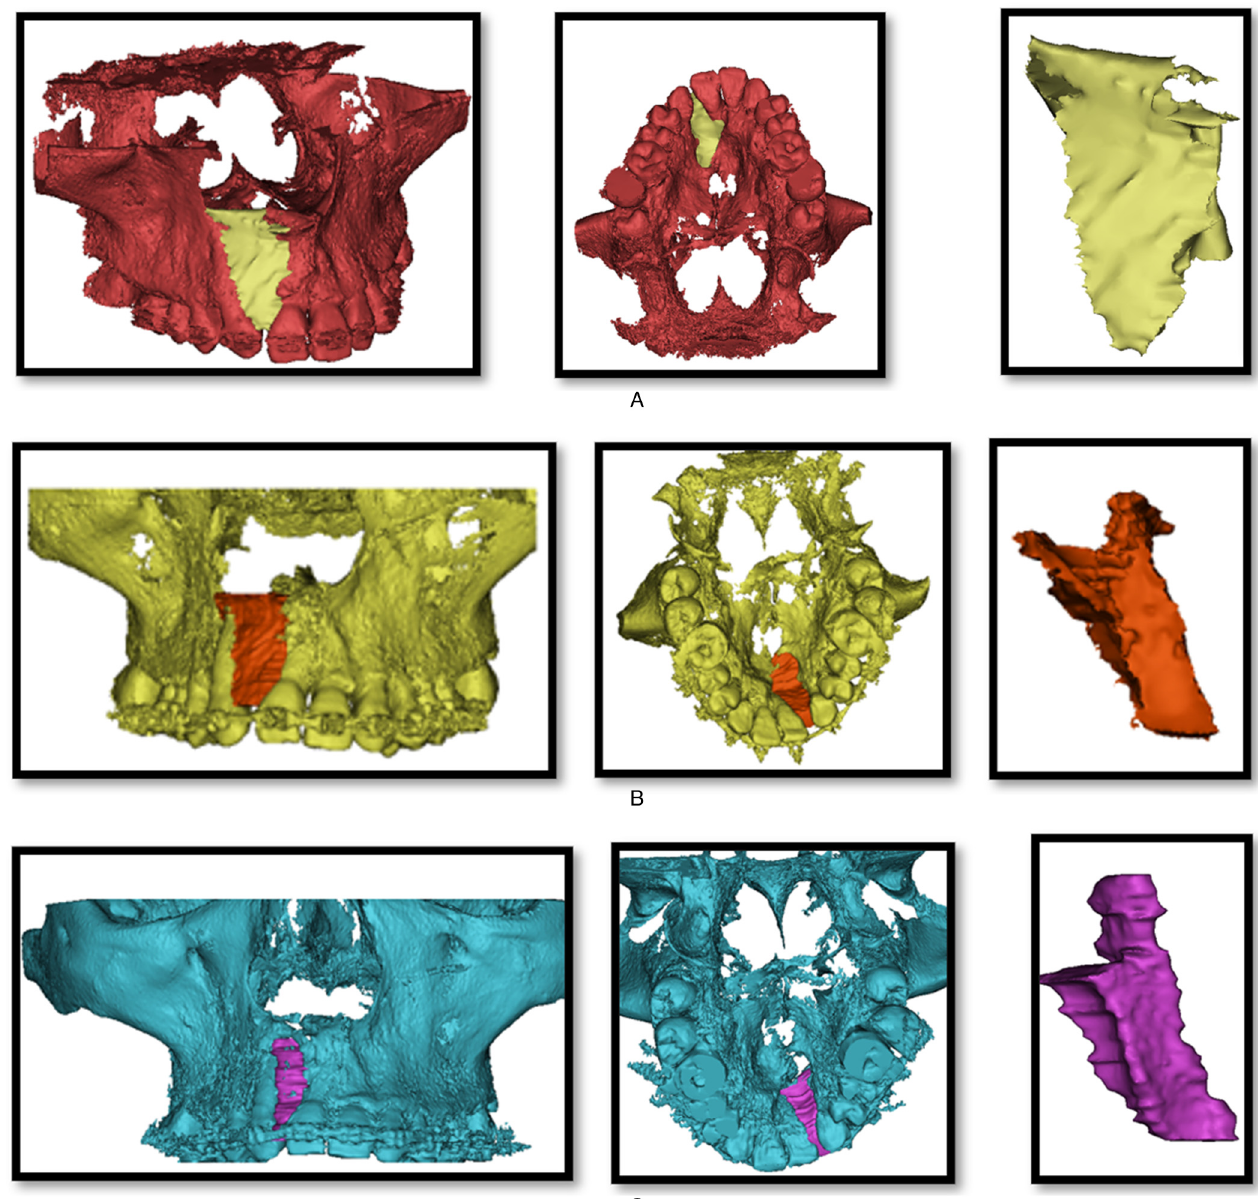
Fig. 2. Volumetric analysis of the residual cleft defect of the same patient. (A) Preoperative images. (B) Intraoperative images. (C) Postoperative